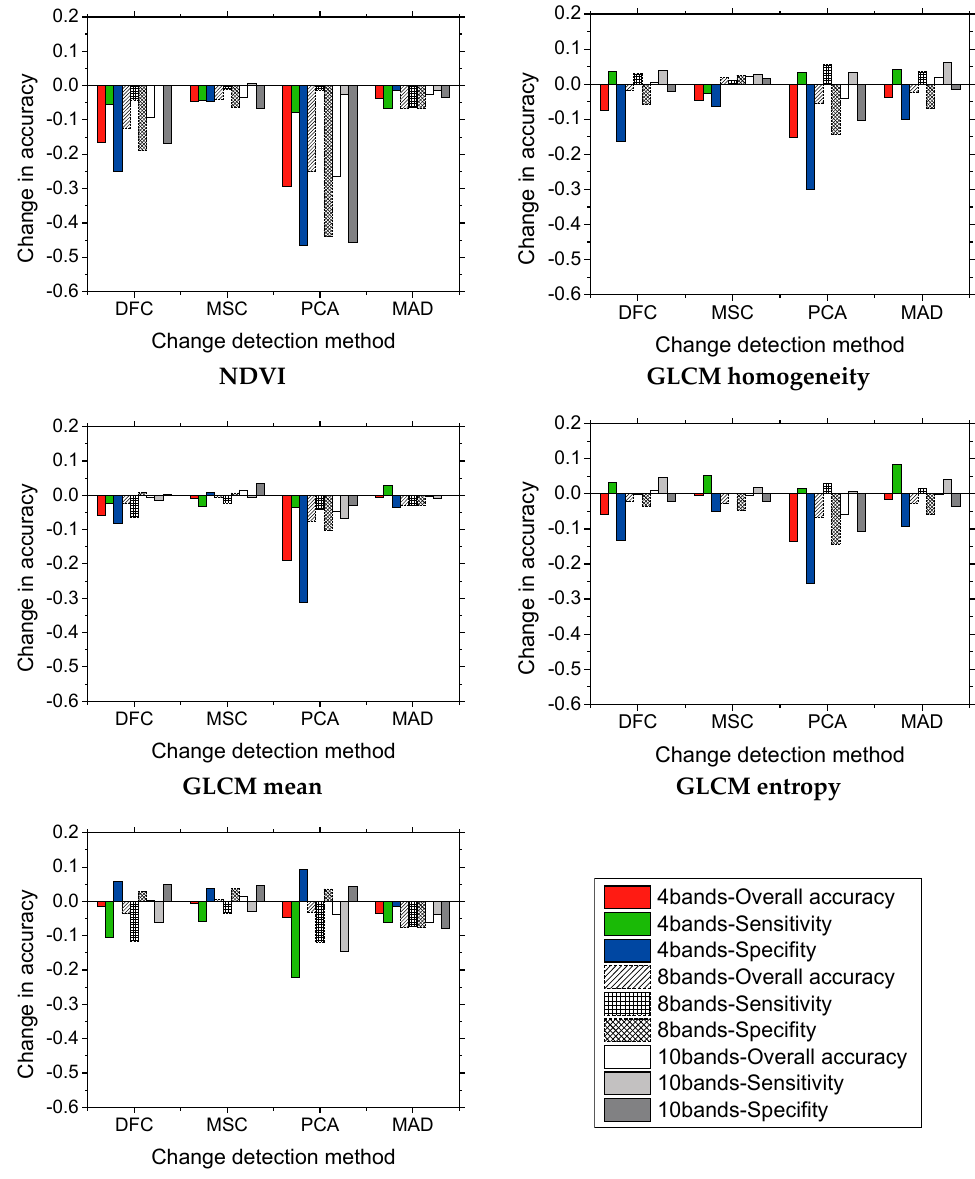
Figure 8. Changes in the three measures of accuracy for Study site 2 (0.1 indicates 10%) following the addition of object-level textural and NDVI information. Scale: 140.